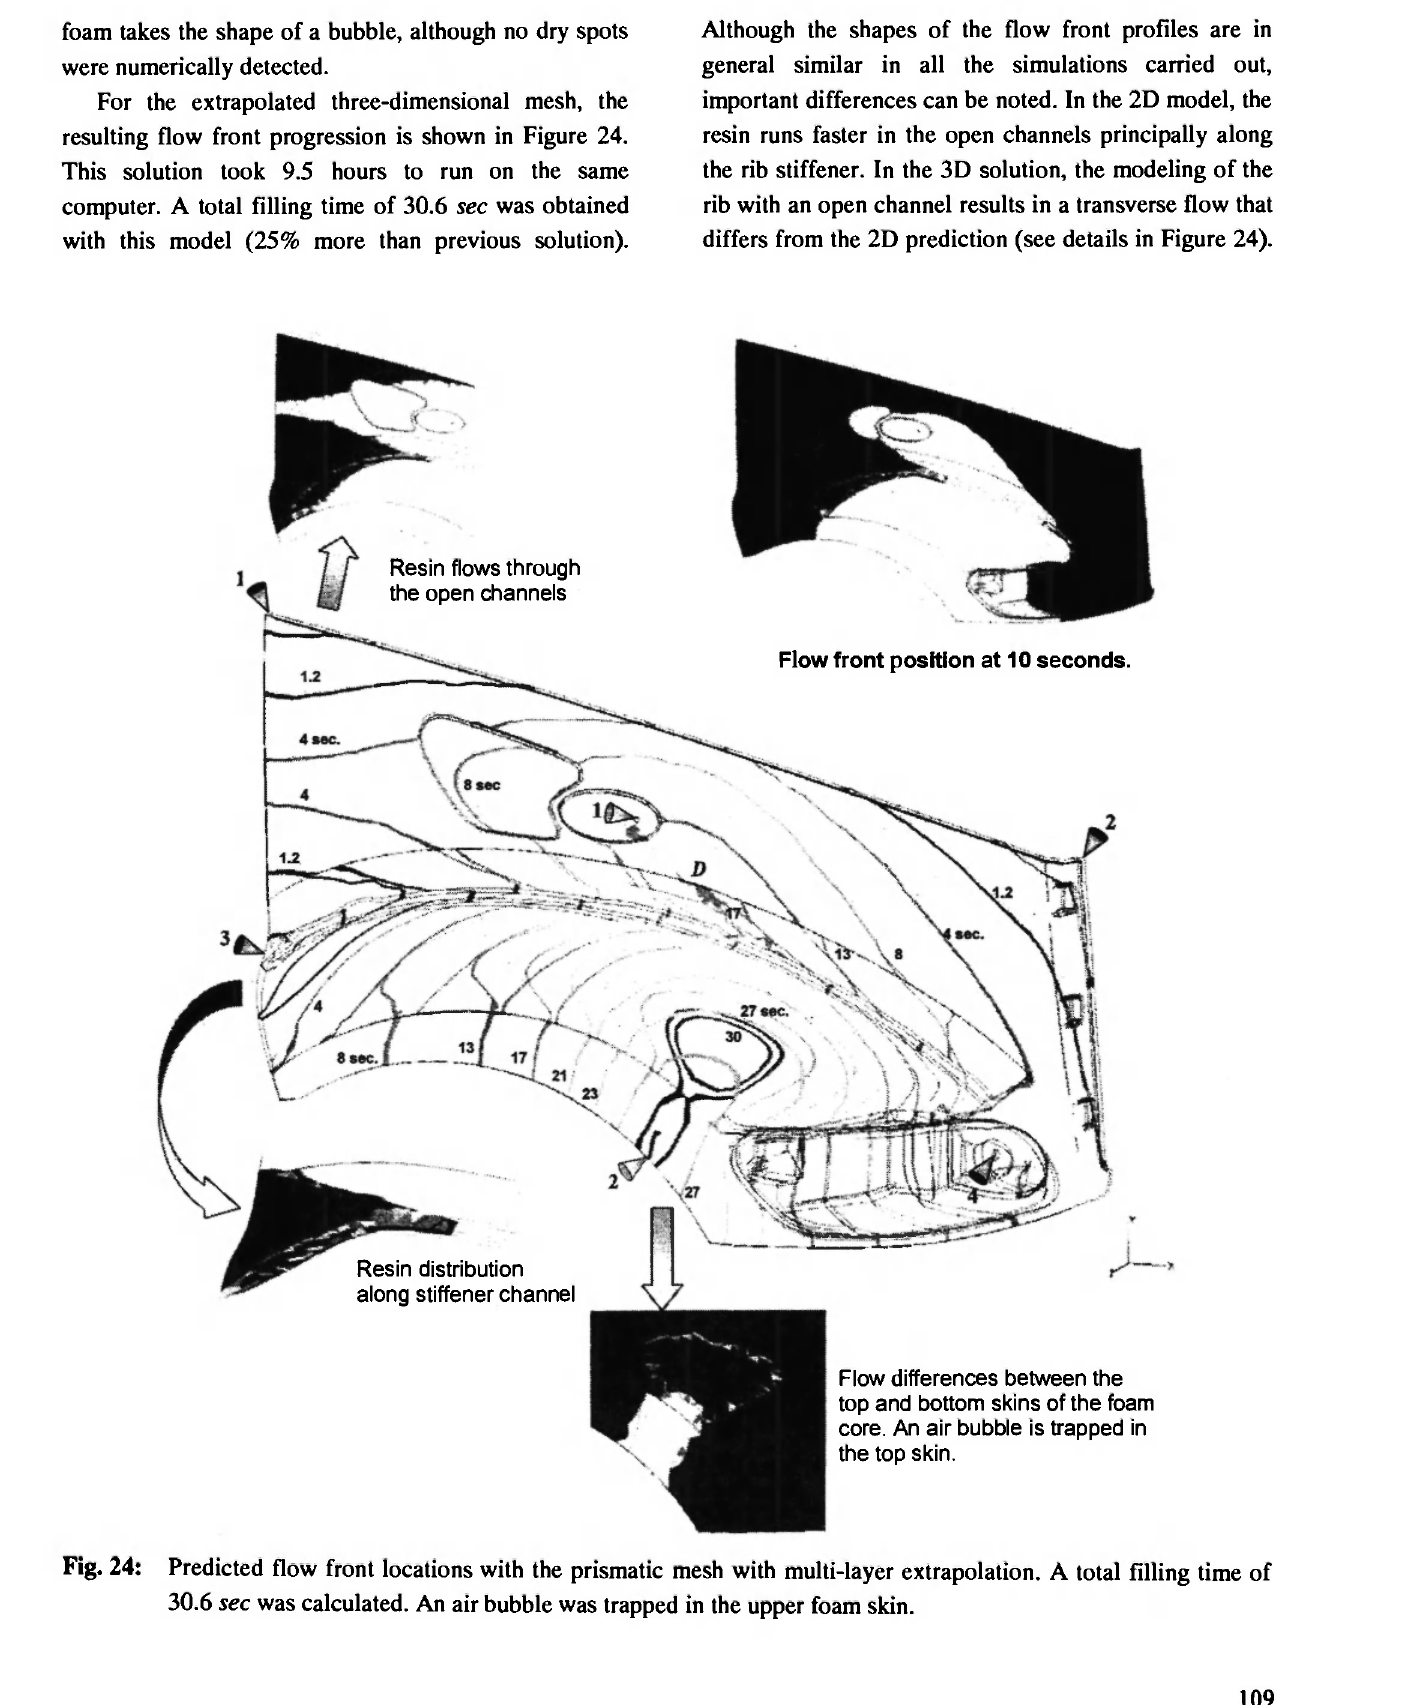
Predicted flow front locations with the prismatic mesh with multi-layer extrapolation. A total filling time of 30.6 sec was calculated. An air bubble was trapped in the upper foam